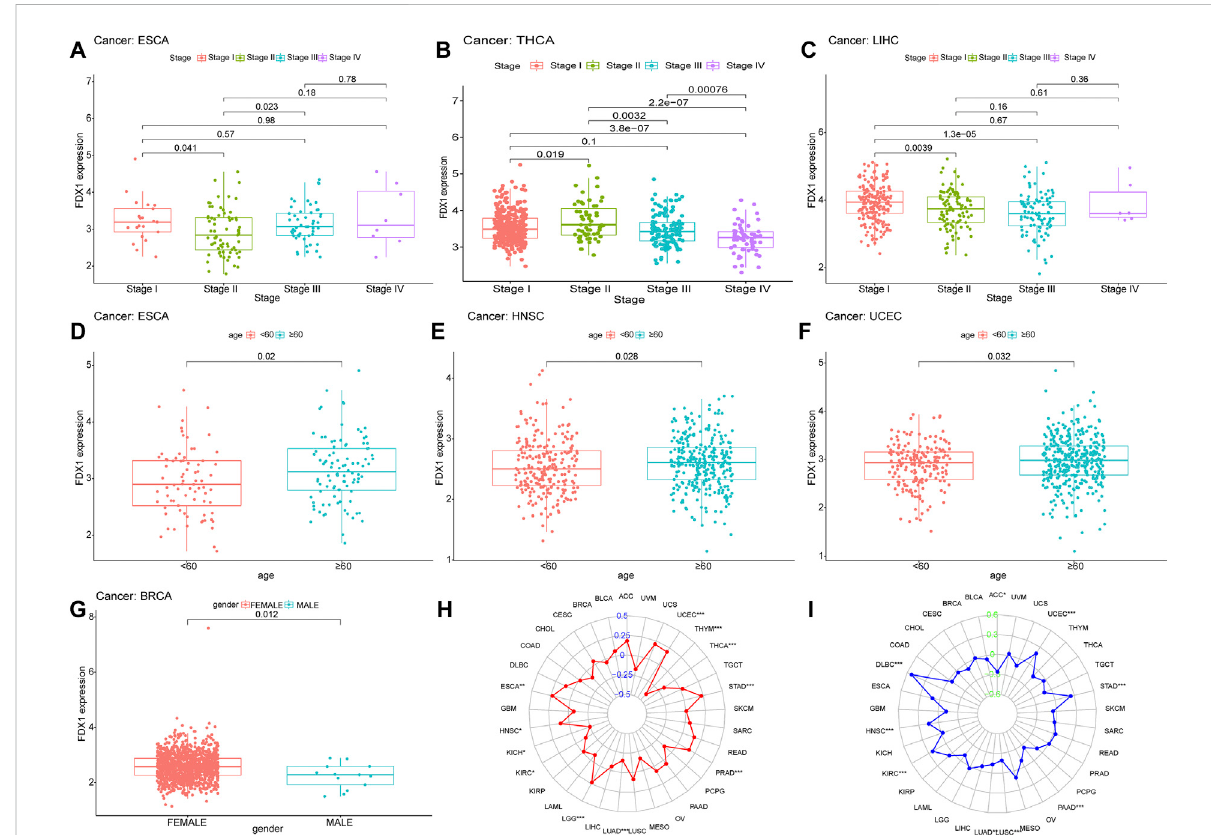
FIGURE 4 AnalysisofcliniccorrelationofFDX1expression.CorrelationanalysisofFDX1expressionandtumorclinicalstage (A) ESCA (B) THCA (C) LIHC.The red, green, blue, and purple boxplots represent stage I-IV, respectively. Correlation analysis of FDX1 expression and age (with 60 years as the cutoff) ofcancerpatients (D) ESCA (E) HNSC (F) UCEC.Redmeansthepatientisyoungerthan60yearsold,andbluemeansthepatientis60yearsorolder (G) Correlation analysis of FDX1 expression with gender in cancer patients. Relationship of FDX1 expression with TMB (H) and MSI (I)